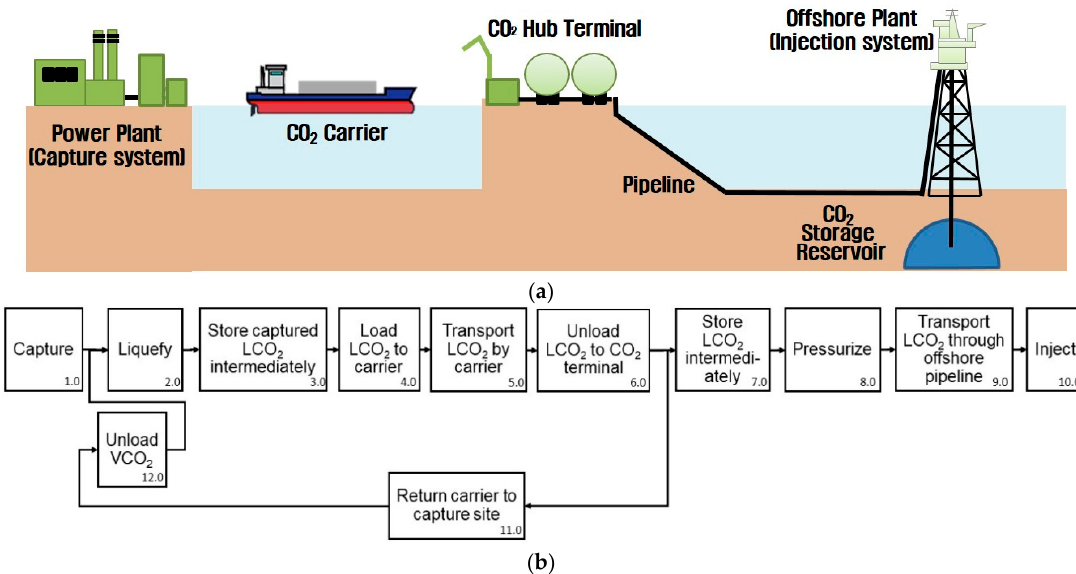
Figure 2. The carbon capture and storage (CCS) chain process in this study: ( a ) graphical representation and ( b ) functional flow block diagram. L = liquid, V = vapor.